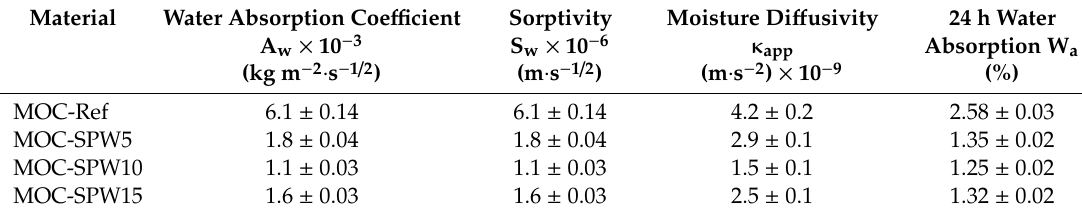
Table 7. Hygric parameters of MOC